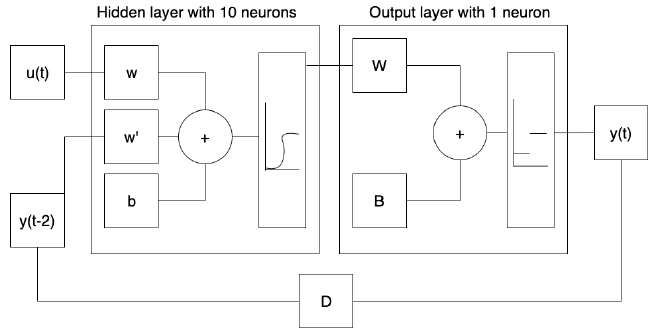
Figure 1. Nonlinear autoregressive exogenous neural network (NARX) model